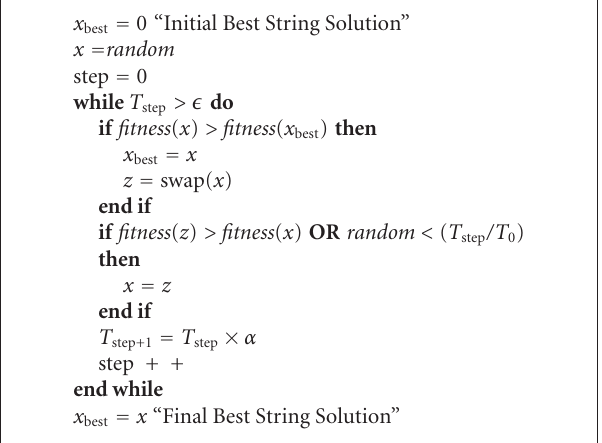
Algorithm 2: SA RTSPP Final